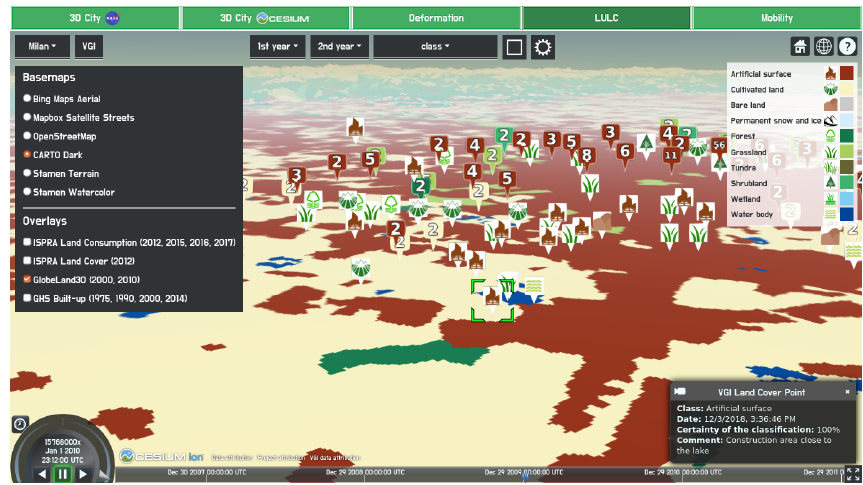
Figure 13. Clusters of volunteered geographic information (VGI) on a virtual globe created using CesiumJS.